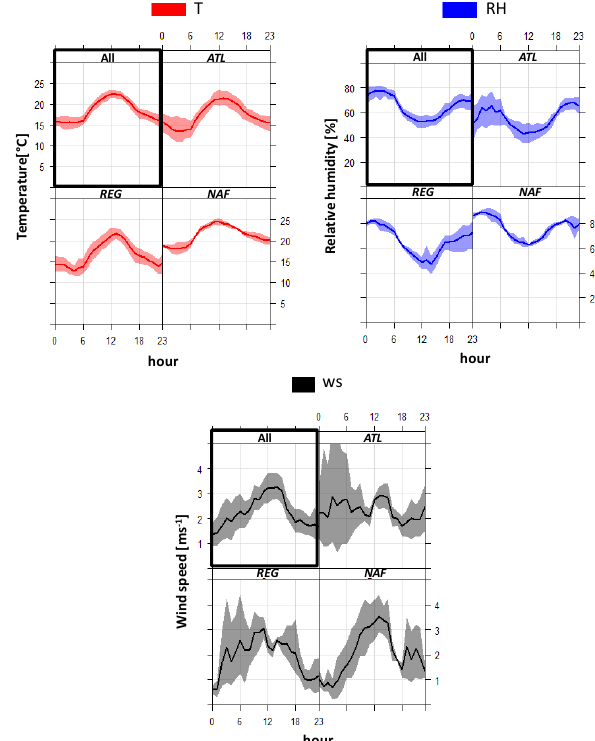
Fig. 1a. Diurnal cycles of SML [m], DRCL [m], aerosol backscatter coefficients at 500m ( β 500 ) and 800m a.g.l. ( β 800 ) [Mm − 1 sr − 1 ], and PM 1 concentrations [µgm − 3 ] calculated for the entire SAPUSS campaign (All) and for the ATL, REG, and NAF scenarios.